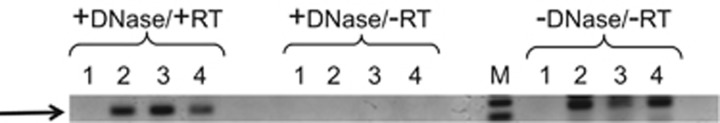
RT–PCR amplification of nifH mRNA from wood-fed P. nigrolineatus GI tract regions. After dissection, RNA was extracted from fore (lane 2), hind (lane 3) and midgut (lane 4) regions, as described in the materials and methods section. RNA (3 μg) was first treated with DNaseI in the presence of RNasin and RT–PCR was carried out using the Superscript III One-Step Platinum Taq high fidelity kit (see Methods). Complementary DNA synthesis was followed by amplification with nifH32 and nifH623 primers and a second round amplification using nifH1 and nifH2 primers as described in the materials and methods section. Reaction products were separated on a 1.5% agarose gel. RNA preparations treated with DNase in the absence of RT and amplifications without DNase and RT treatments are shown. M is a 100 bp ladder; lane 1 is a negative control that did not contain RNA.